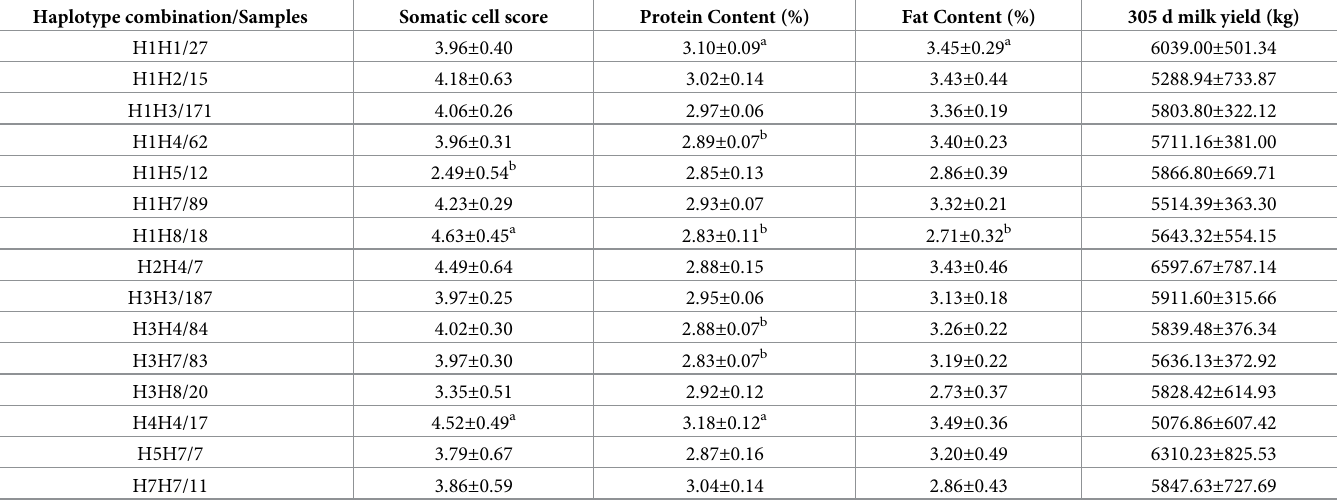
Table 8. Least squares mean (LSM) and standard error (SE) for SCC, fat, protein and milk yield of different C3 haplotype combinations in 821 Chinese Holstein. Haplotype combination/Samples